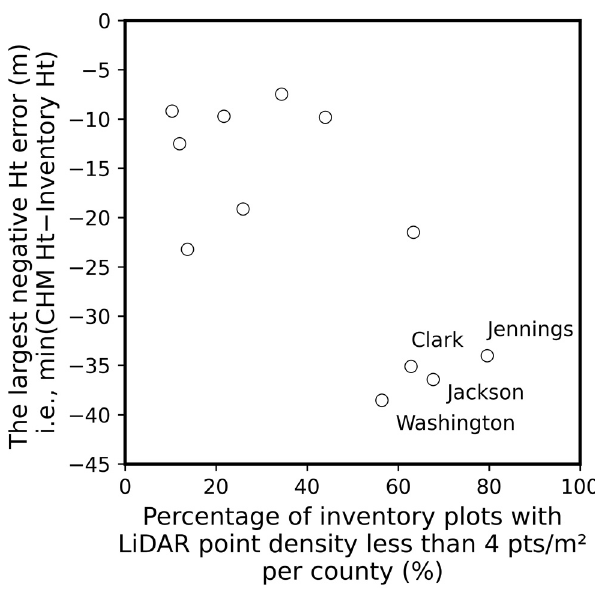
Figure 18. The largest negative height measurement error with respect to the proportion of inventory plots in counties with low LiDAR point density (0–4 points/m 2 ). Data include Indiana counties where 3D Elevation Program (3DEP) LiDAR data was collected in 2018. Counties having 20 or less inventory plots were excluded to highlight a statistical trend. Southeast Indiana counties with a large negative error (Figure 17a) were labeled.